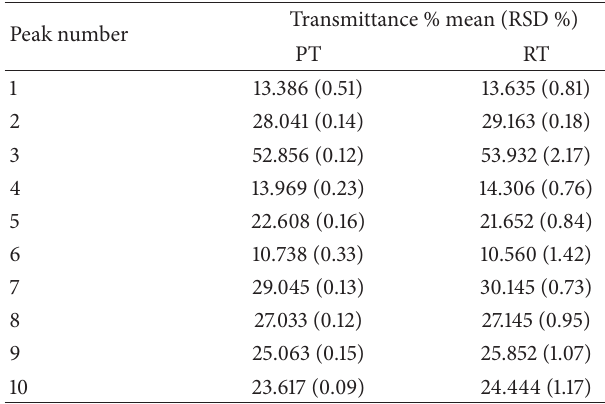
Table 3: FTIR transmittances of the characteristic common peaks of precision and repeatability tests on Plagiomnium acutum